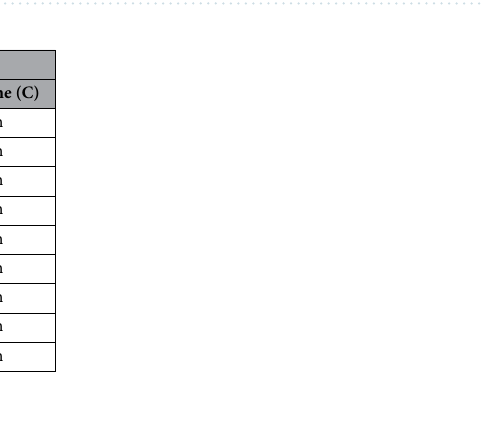
Figure 2. Schematic diagram of working conditions of Zhouqiao site under dry shrinkage and freeze–thaw conditions.